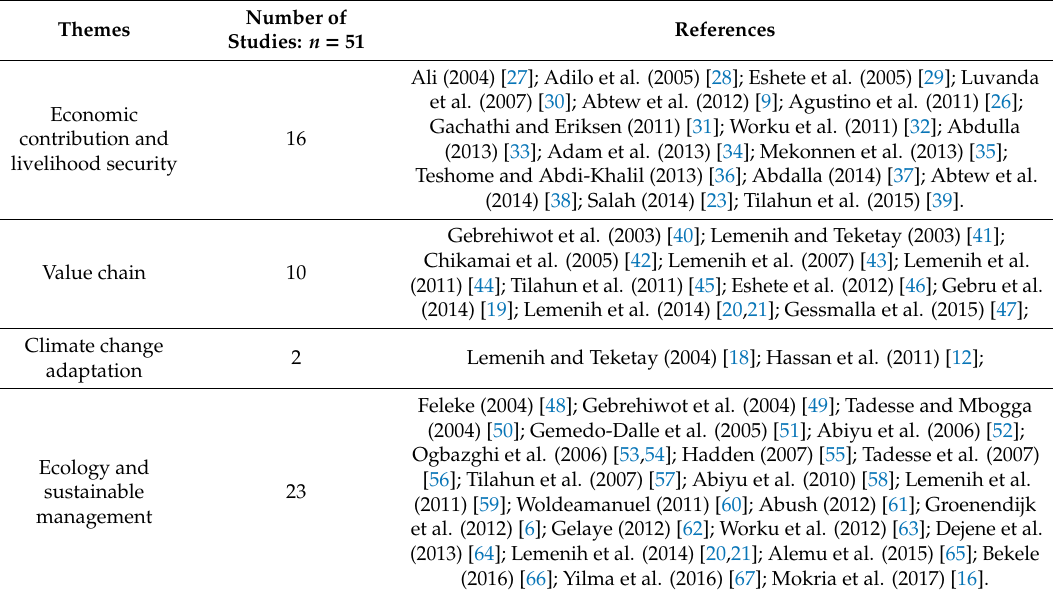
Table 2. Aromatic resins with reference to ecological impacts, adaptation to climate change and rural livelihood security in the Horn of Africa